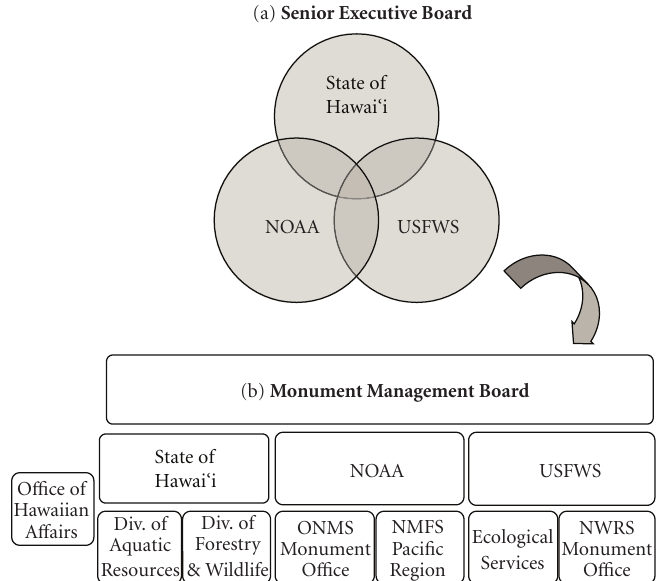
Figure 2: Polycentric governance arrangement for partner agencies that manage the Papah¯anaumoku¯akea Marine National Monument. Operational decisions are made at the level of the Monument Management Board (b), which is overseen by a higher-level Senior Executive Board (a) comprised of senior managers from each of the three co-trustee agencies. The Monument Management Board is comprised of members from seven di ff erent resource management agencies. Abbreviations are as follows: NOAA: National Oceanic and Atmospheric Administration; USFWS: US Fish and Wildlife Service; ONMS: O ffi ce of National Marine Sanctuaries; NMFS: National Marine Fisheries Service; Div.: Division; NWRS = National Wildlife Refuge System (administers the Hawaiian and Pacific Islands NWR Complex, which includes Papah¯anaumoku¯akea Marine National